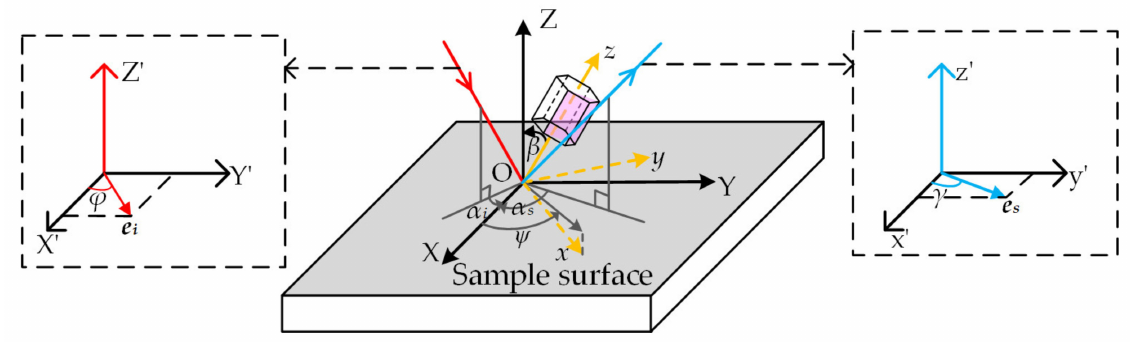
Figure 4. Definitions of coordinate systems and angle